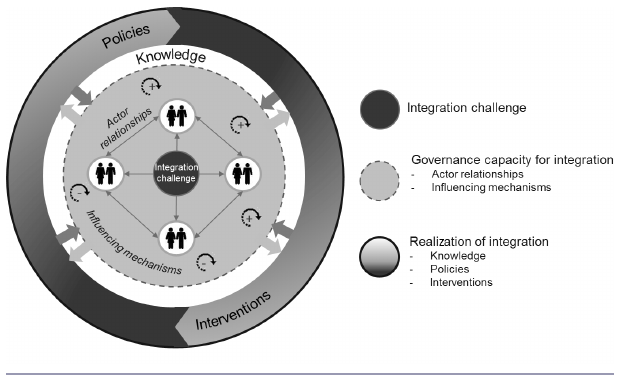
Fig. 1 . Conceptualization of the interconnectivity between the dimensions and elements of